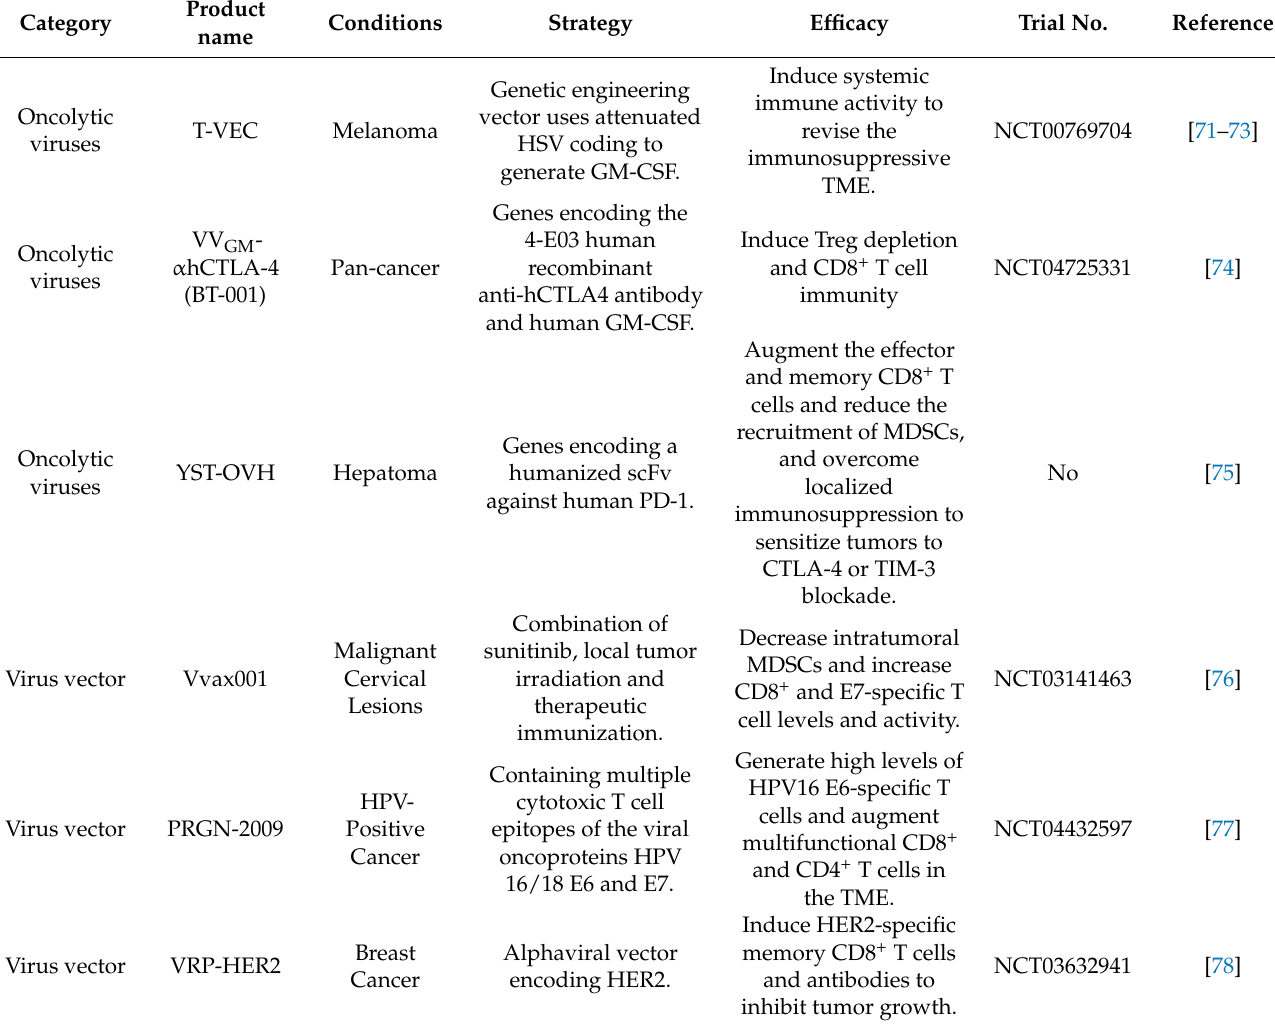
Table 5. Virus-based cancer vaccines and their efficacy on the solid